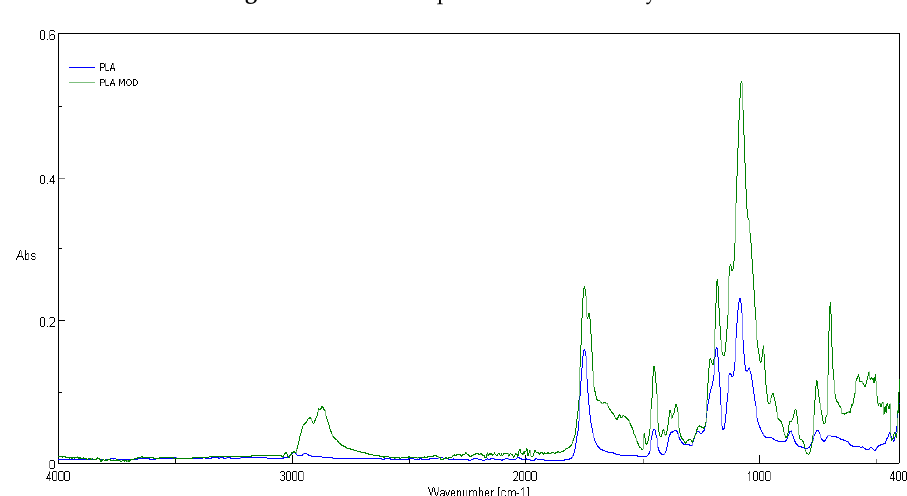
Figure 5. ATR-FTIR spectrum of the polylactide nonwoven (PLA) and nonwoven sample coated by paste concentrations 0 . 1%fosfomycin (PLA-MOD).